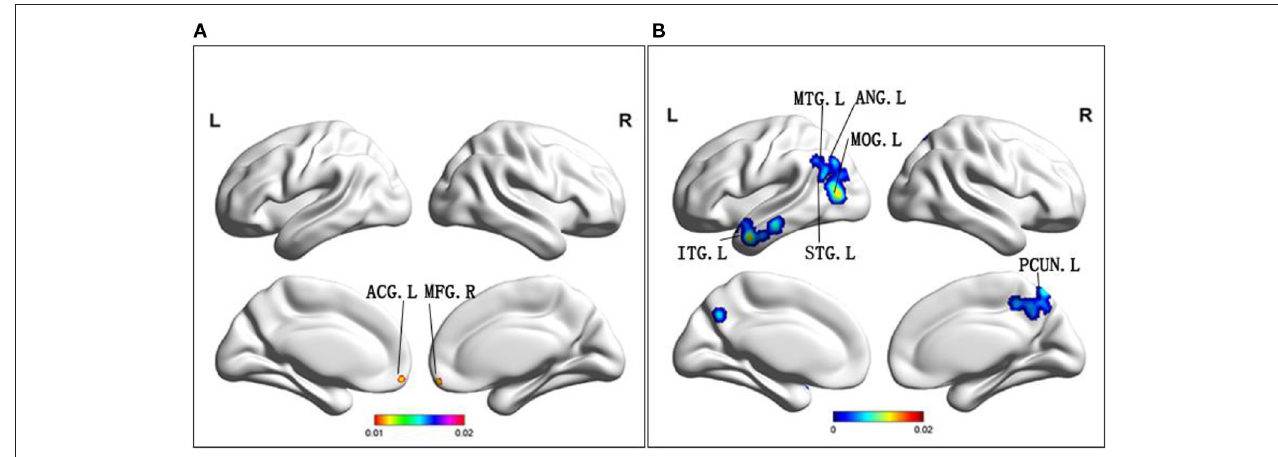
FIGURE 4 | (A) Brain regions showing increased FC in MCI patients compared to HCs. (B) Brain regions showing decreased FC in MCI patients compared to HCs. MCI, amnestic mild cognitive impairment; FC, functional connectivity; HCs, healthy controls; ACG, anterior cingulate gyrus; MFG, middle frontal gyrus; ITG, inferior temporal gyrus; MTG, middle temporal gyrus; STG, superior temporal gyrus; ANG, angular gyrus; MOG, middle occipital gyrus; PCUN, precuneus; R, right; L,